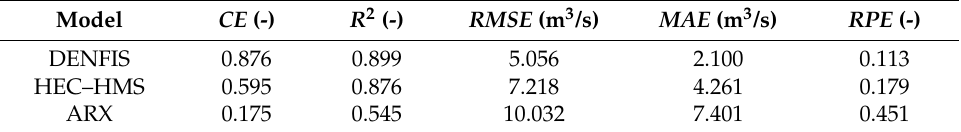
Table 4. Average CE , R 2 , RMSE , MAE , and RPE values over the 18 testing events resulted by Dynamic Evolving Neural Fuzzy Inference System (DENFIS), Hydrologic Engineering